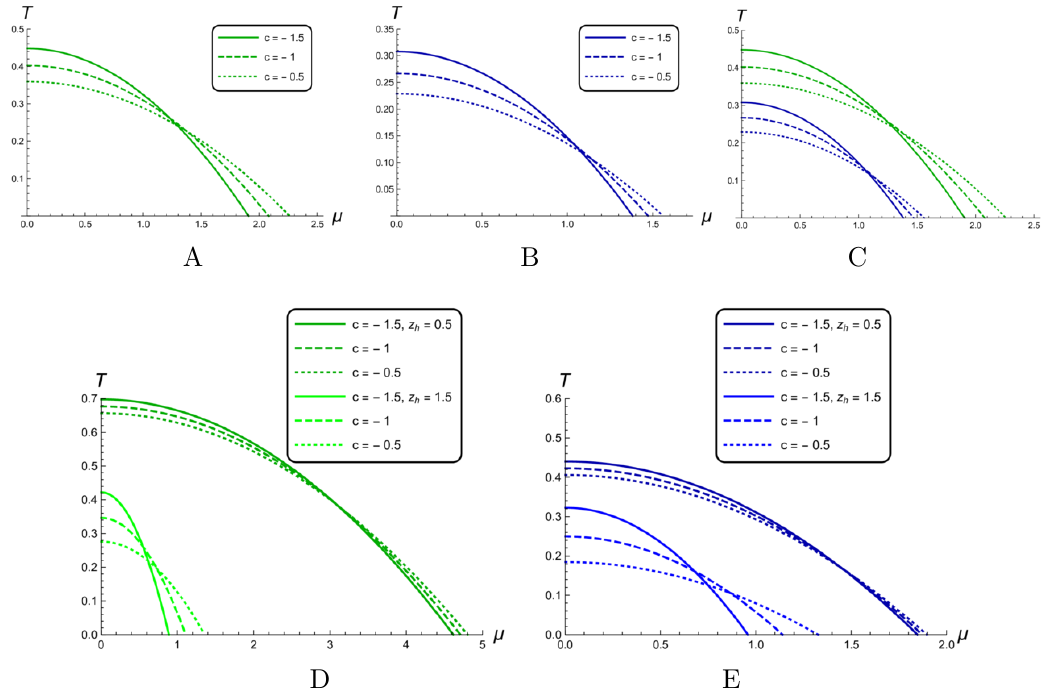
Figure 20 . The dependence of temperature T ( z h ; (cid:22); c; (cid:23) ) on (cid:22) for z h = 1 and di(cid:11)erent c in isotropic (A) and anisotropic, (cid:23) = 4 : 5, (B) cases, their the comparison with the same line labels (C); for small black holes with z h = 1 : 5 and large black holes with z h = 0 : 5 and di(cid:11)erent c in the isotropic (D) and anisotropic, (cid:23) = 4 : 5, (E)